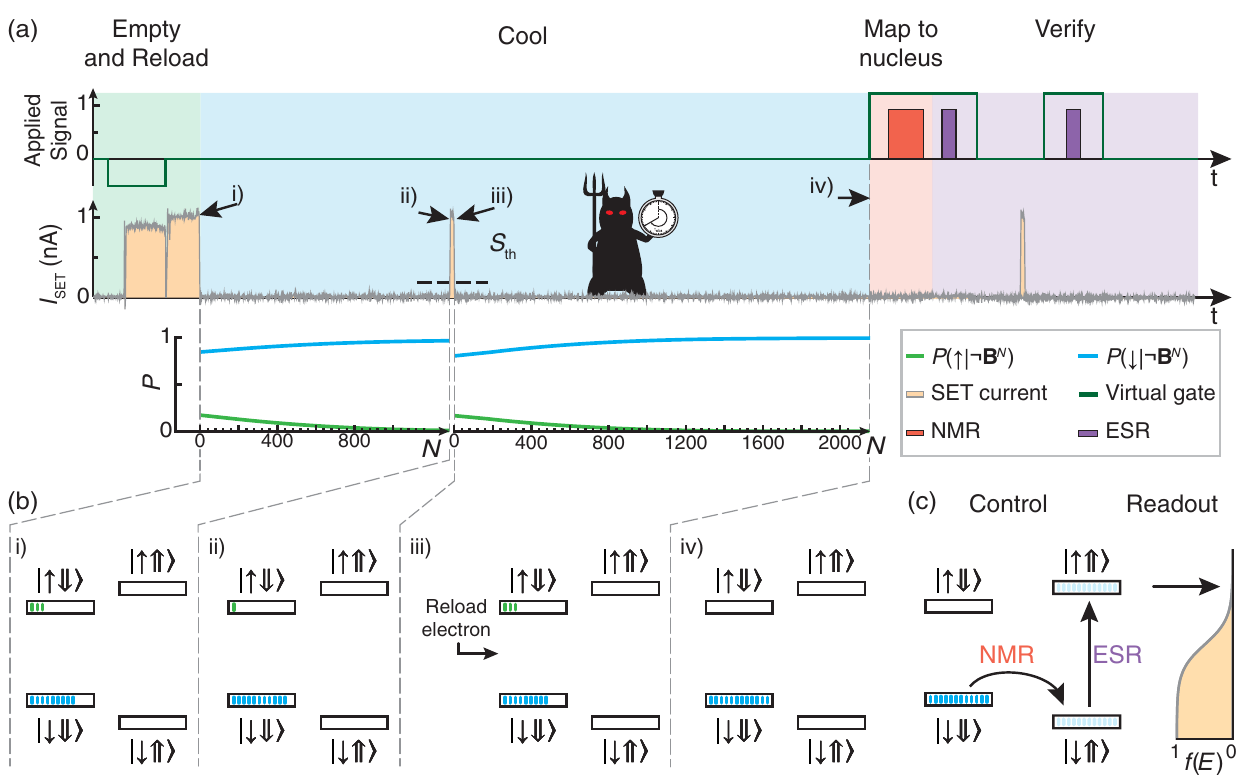
FIG. 3. Electron spin initialization with Bayesian Maxwell ’ s demon. (a) A pulse on the virtual gate VG first empties the donor to remove the electron and then returns to the initialization position ( μ D ¼ E F ) to reload an electron from the SET island. The electron loading is signalled by I returning to approximately 0. A Maxwell ’ s demon (in this case, the FPGA that processes the values of I ) SET SET observes the digital trace with a stopwatch to count to NT s ¼ t , resetting the stopwatch when a tunneling event occurs. After a time obs t of measuring the electron not tunneling, the electron is labeled as j ↓ i with high confidence. (b) The electron spin populations are obs shown at each point (i) – (iv) from (a), indicated by individual ticks. The j ↓ i population increases with increasing t , but the spin obs preparation is lost if the electron tunnels away from the donor. The demon automatically restarts the process until a long enough stretch with no tunnel-out events is observed. (c) Finally, the electron spin preparation is mapped to a nuclear spin flip with an NMR pulse, and the nuclear spin is read out via repeated ESR. The initial nuclear spin state ( j ⇓ i ) and the prior spin-down probability [ P ð ↓ Þ ¼ 0 . 75 ] are chosen for illustration